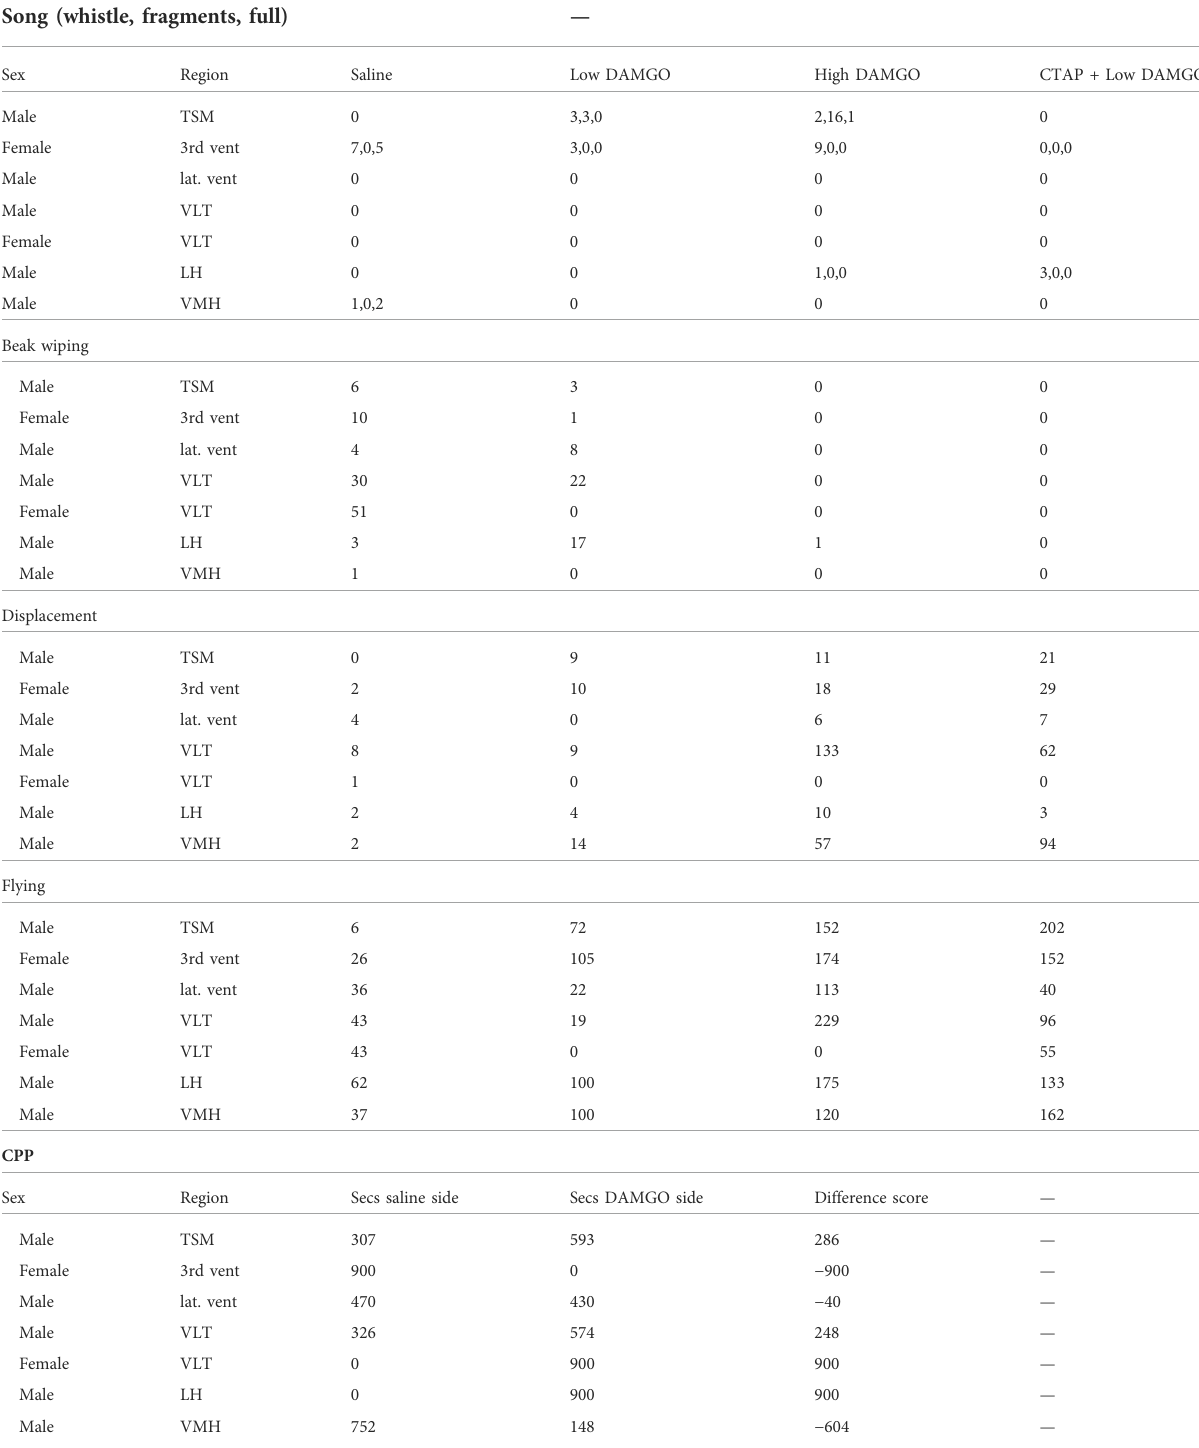
TABLE 1 Effects on behavior of DAMGO infusions outside NAC or